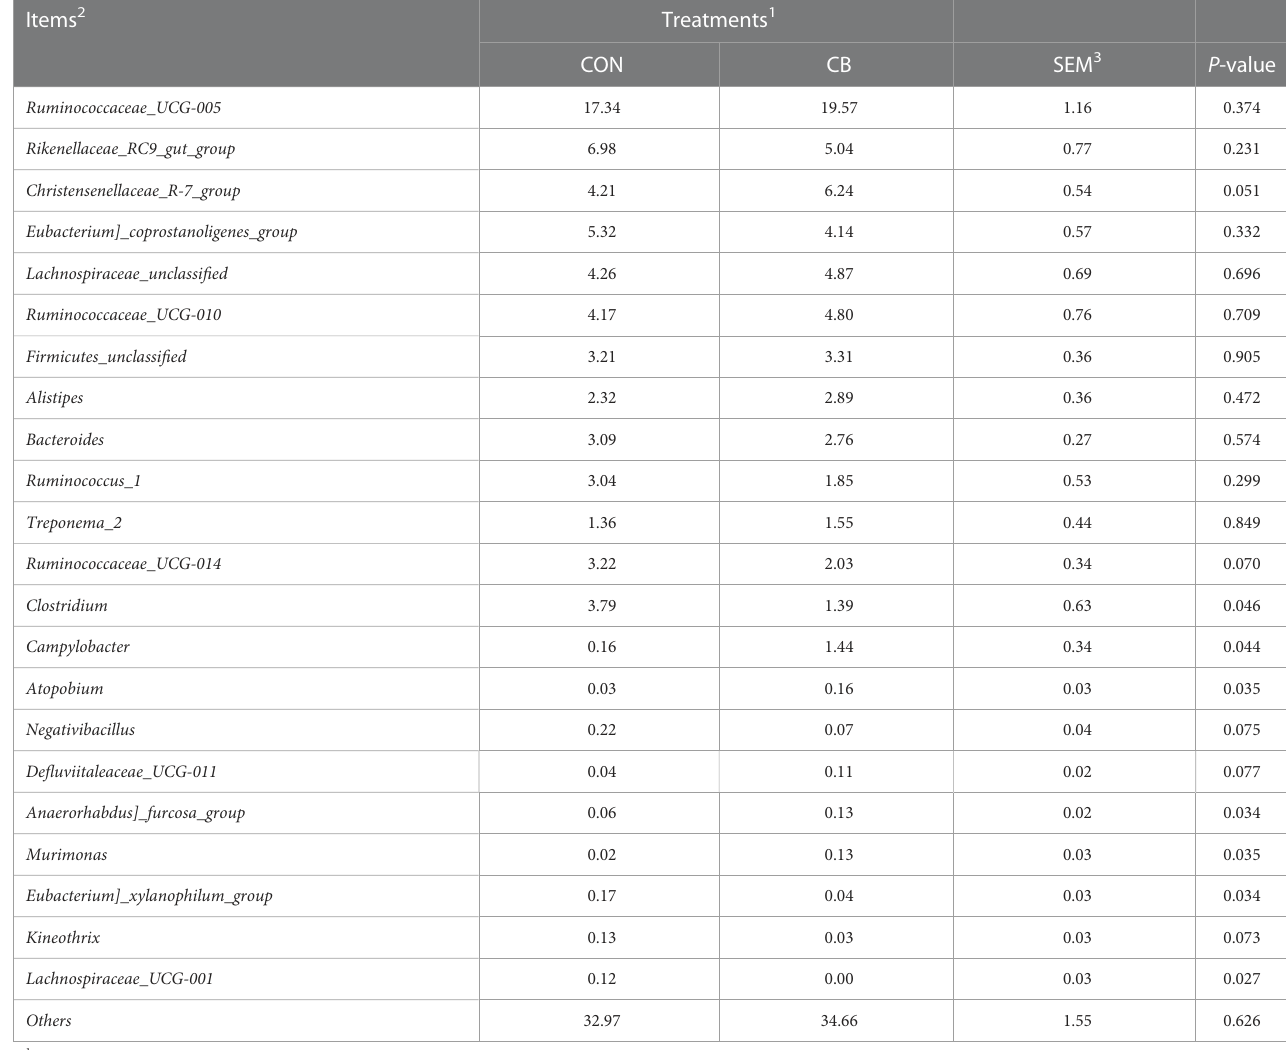
TABLE 2 Effects of C. butyricum on the rectal microbiota of goats at the genus level. Items